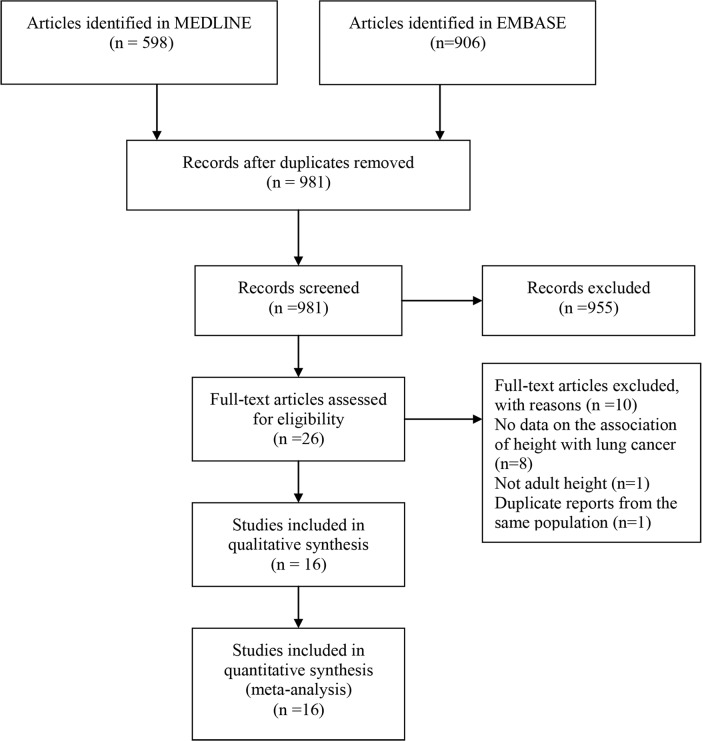
Flow diagram of the literature search.